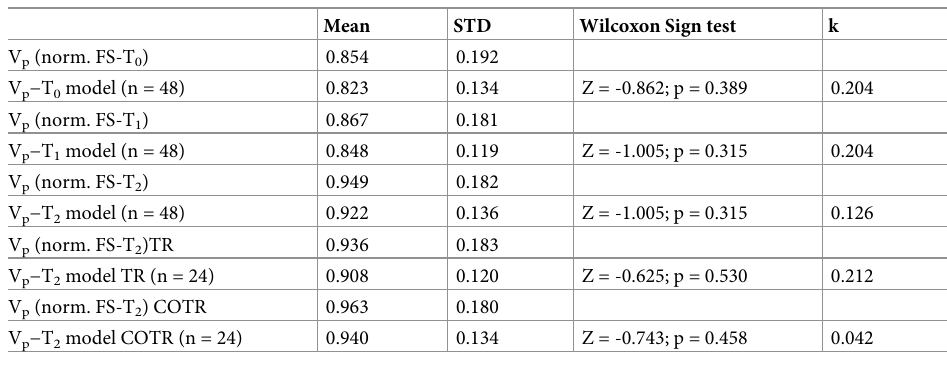
Table 5. Hyperbolic effort model fit.